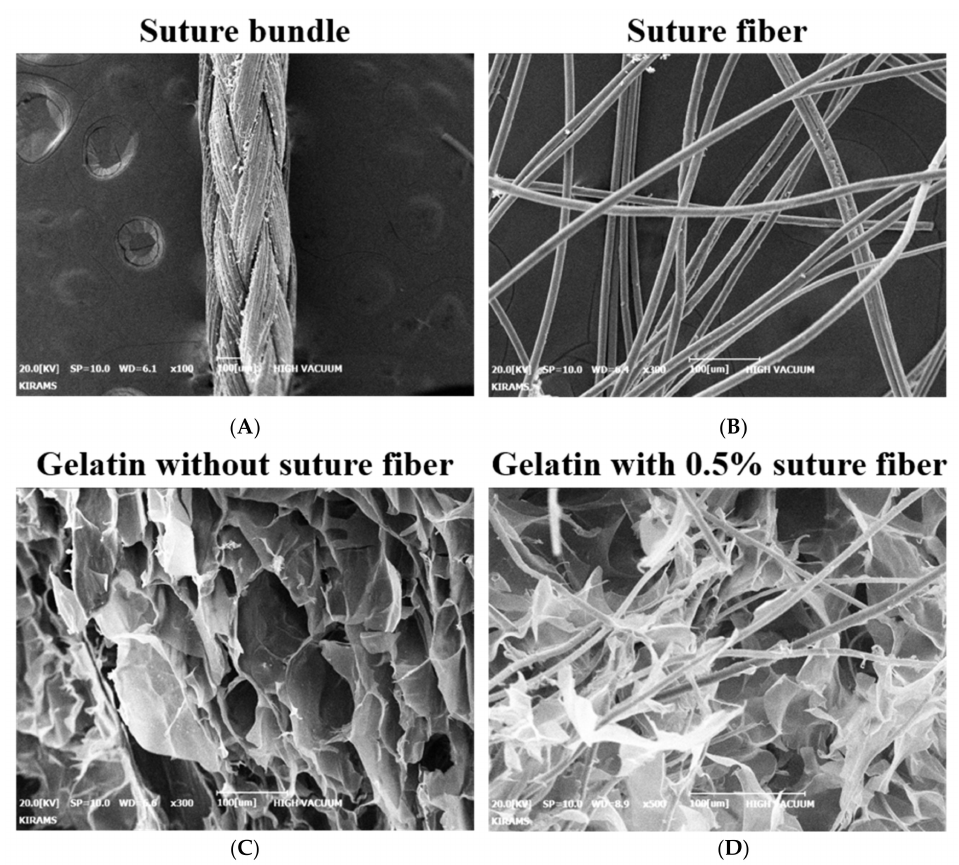
Figure 1. The SEM images of suture (bundle/fibers) and suture fibers added gelatin biomaterial ink. Suture ( A ) bundle and ( B ) fiber. Gelatin biomaterial ink ( C ) without suture fibers and ( D ) with suture